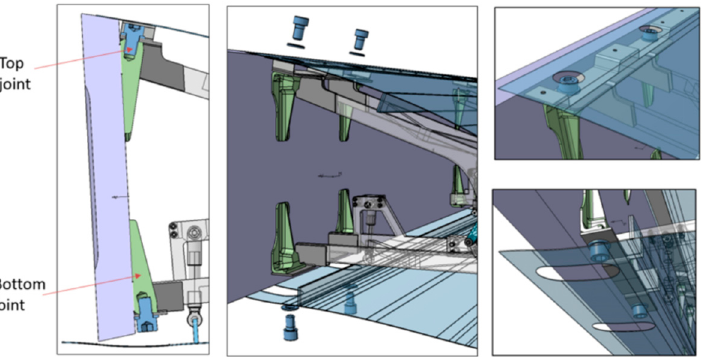
Figure 30. Joining elements for MLE attached to the front spar ( left ) and supporting stiffening elements on opposite side ( right ).